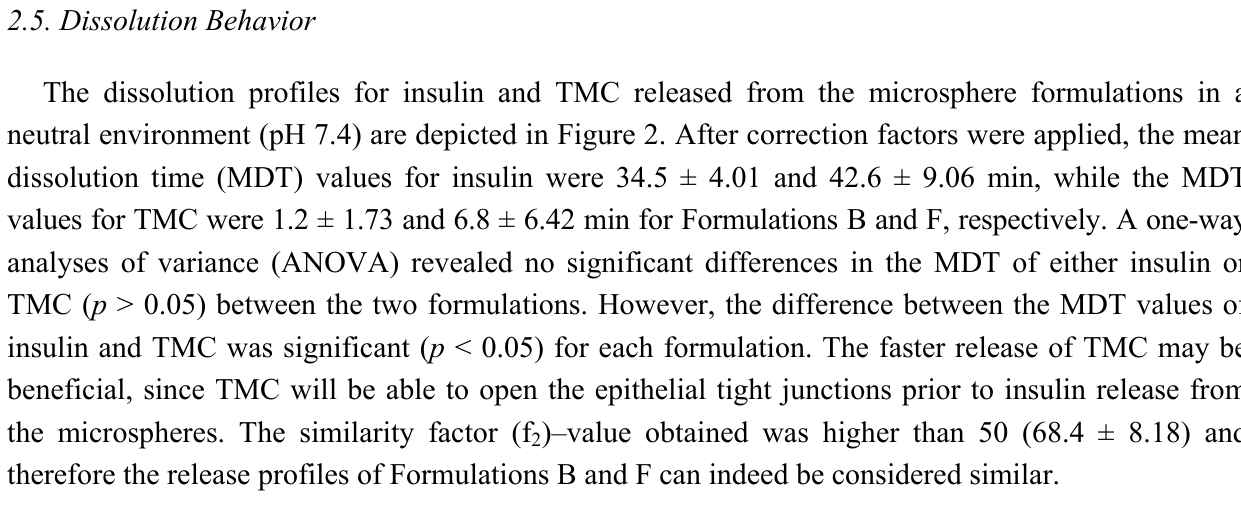
Figure 2. Insulin and TMC dissolution profiles of microsphere formulations B and